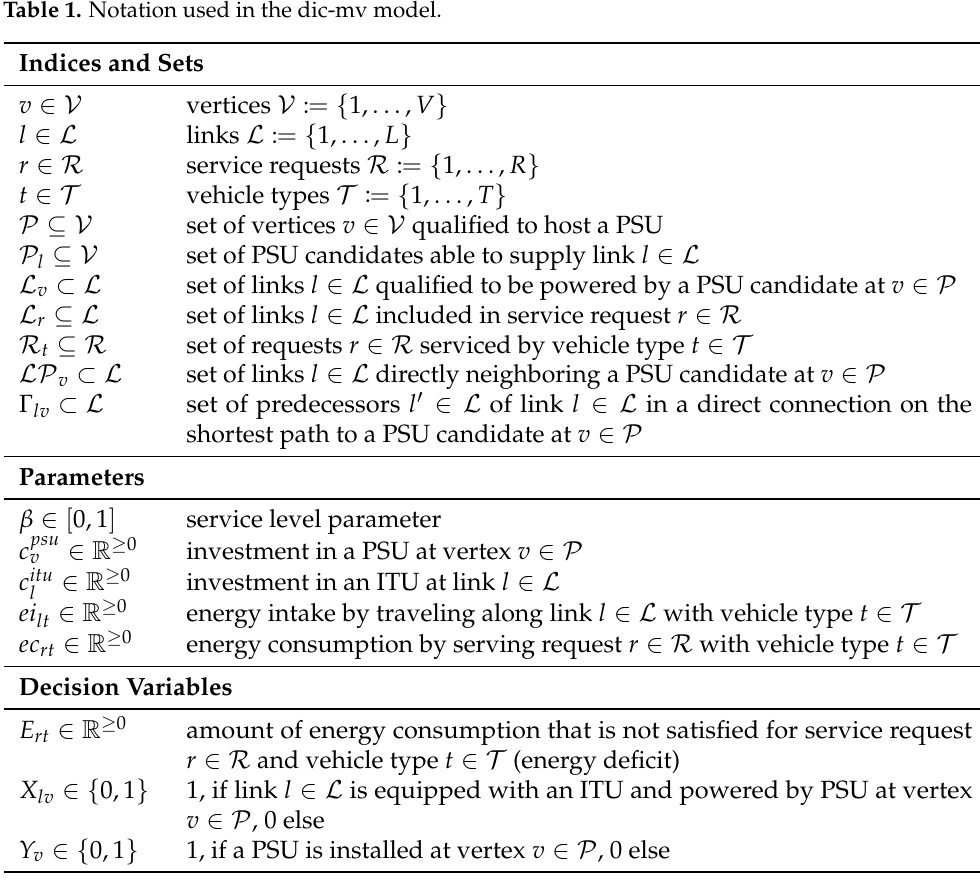
Table 1. Notation used in the dic-mv